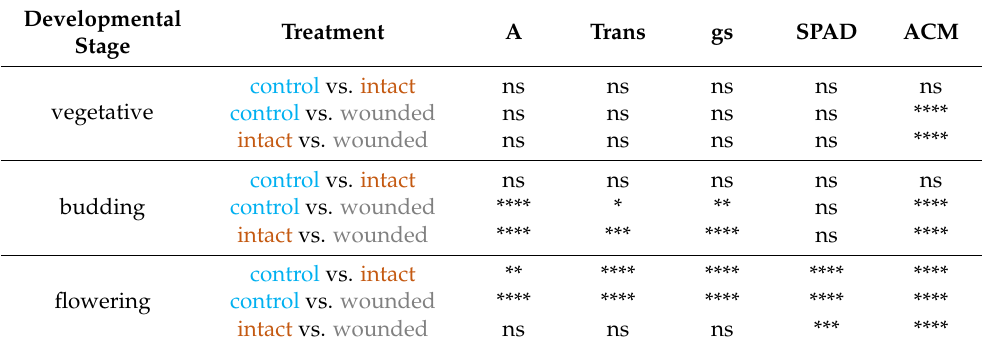
Figure 7. Heatmap of the Pearson coefficient analysis (r values) of the studied plant developmental stages and treatments. Table 1. Comparison of the treatments in different developmental stages (statistical significance according to one-way